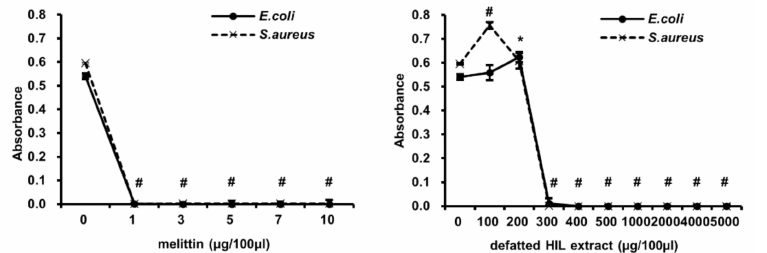
Figure 3. Determination of MIC of melittin and defatted HIL extract against E. coli and S. aureus . Briefly, 1 × 10 6 cfu/mL of 90- µ L E. coli or S. aureus suspension was treated with various concentrations of 10- µ L melittin or defatted HIL extract dissolved in 0.05% acetic acid solution. Then, bacteria were grown for 24 h at 37 ◦ C. The experiments were independently performed in triplicate. A concentration of 0 µ g/100 µ L of melittin and defatted HIL extract indicated 0.05% acetic acid alone. The statistical analysis was performed by Student t -test. The significant differences were determined by comparing the absorbance of each experimental group with the control (0 µ g/100 µ L). Each value represents the means ± standard deviations of absorbance. * and # indicate p < 0.05 and p < 0.0001, respectively.